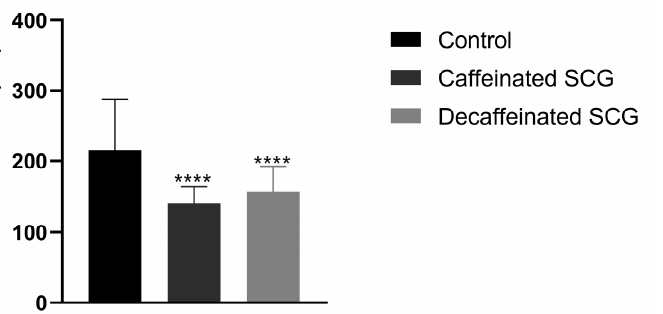
Figure 4. Measurement of C. parapsilosis cell wall thickness of non-treated fungal cells (control), treated with caffeinated SCG extract (275 µg/mL), and treated with decaffeinated SCG extract (150 µg/mL). Results are the mean ± the standard error of the mean of one experiment, **** p < 0.0001 (Dunnett’s post-hoc test).